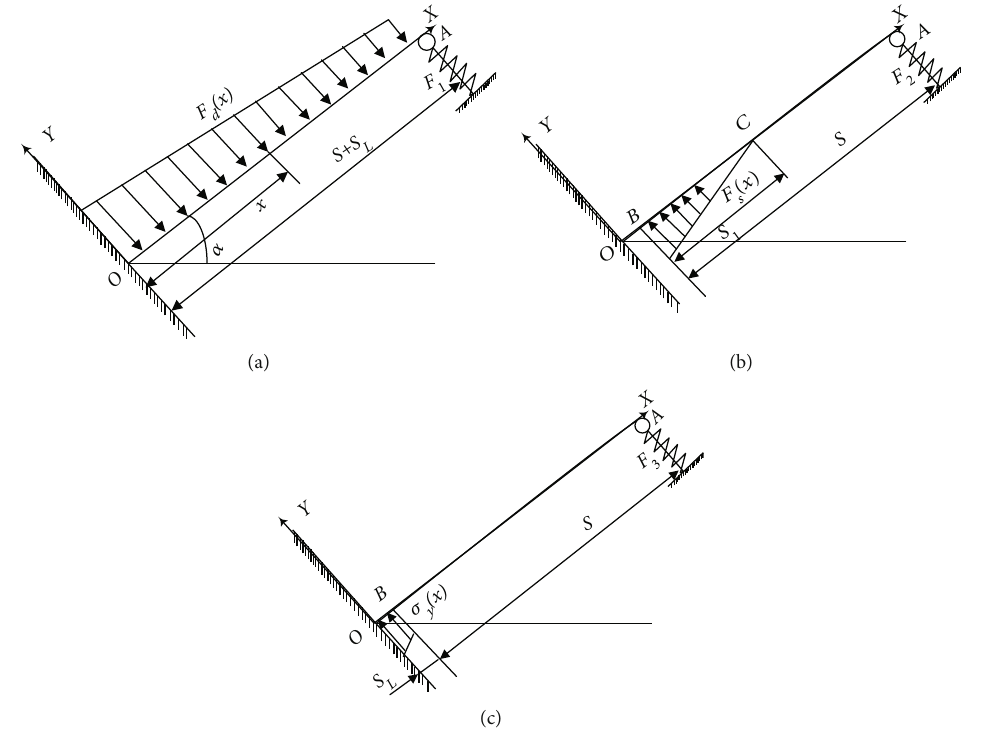
Figure 5: Force analysis of inclined suspended roof